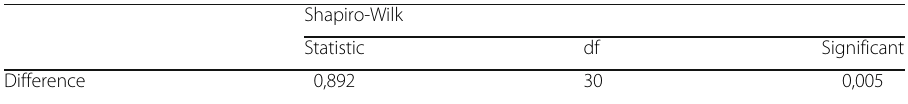
Table 6 Tests of Normality